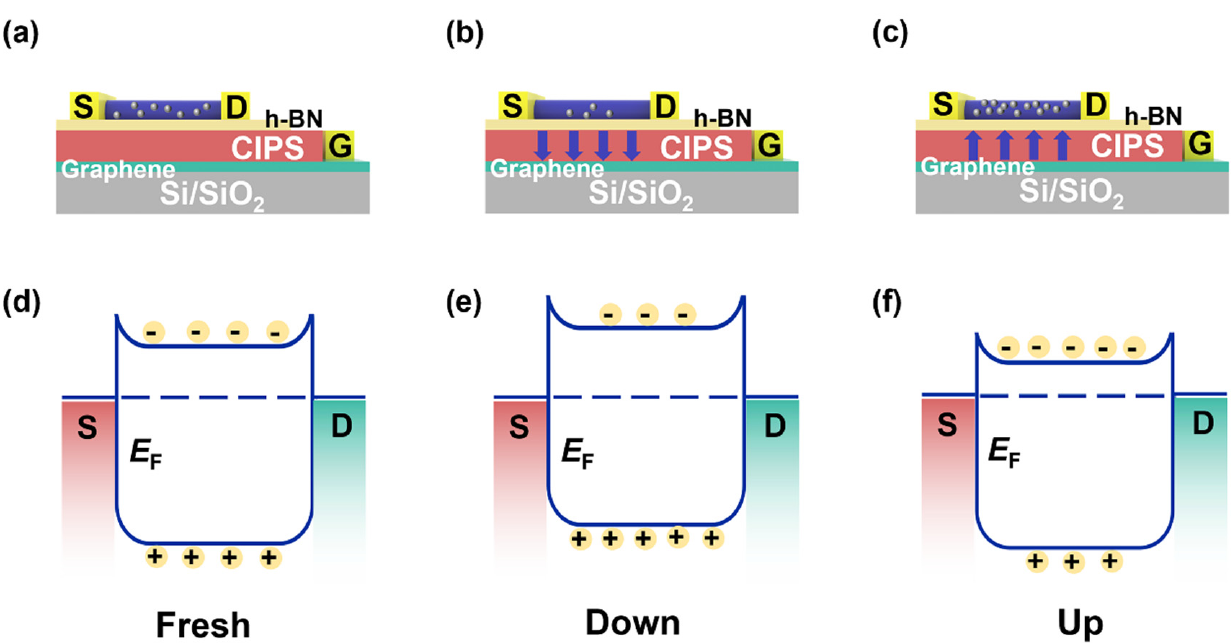
Figure 3. Schematic structure of the ZnO NW Fe–FET device. ( a ) Fresh state, ( b ) Down state, and ( c ) Up state. The corresponding band diagram in the ZnO NW channel when the ferroelectric gate was in ( d ) the Fresh state, ( e ) the Down state, and ( f ) the Up state. E F stands for Fermi level. When the device was applied with a bias voltage of V G = +10 V, the induced electro- static field of the bottom CIPS in the Up state switched to the opposite direction compared to the Down state. After removing the gate voltage, the remnant polarization effect kept the CIPS in a vertically Up state, as shown in Figure 3c. Thus, a large number of electrons accumulated in the ZnO NWs channel, forming an electron accumulation region. In the Up state, due to the accumulation of a large number of carriers, the energy band of the ZnO NWs bent downward, leading to the Fermi level of the ZnO NWs surface rising upwards, as shown in Figure 3f. The carrier concentration in the channel increased, which also increased the dark current compared to that in the Fresh